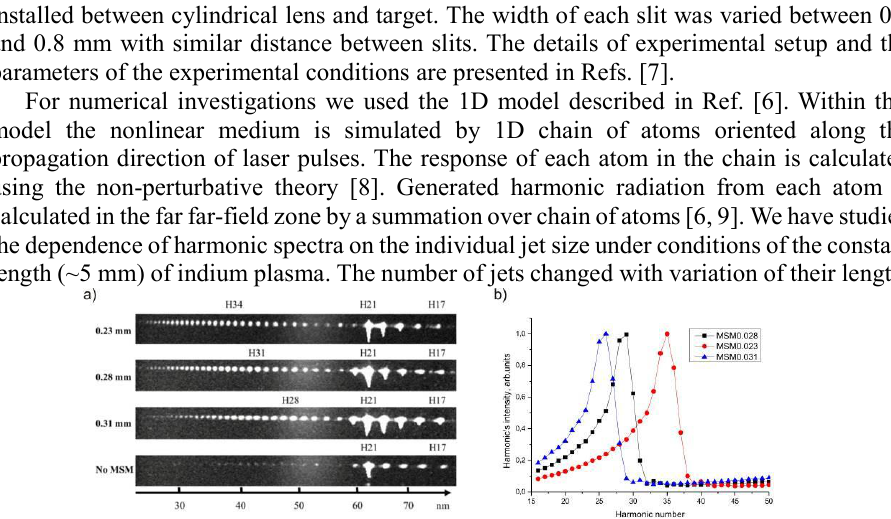
Fig. 1. Raw images of harmonic spectra from indium MJP with the single plasma jet sizes of (top to bottom) 0.23, 0.28, 0.31 mm pumped by two-color pulses: a) experiment [7], b)